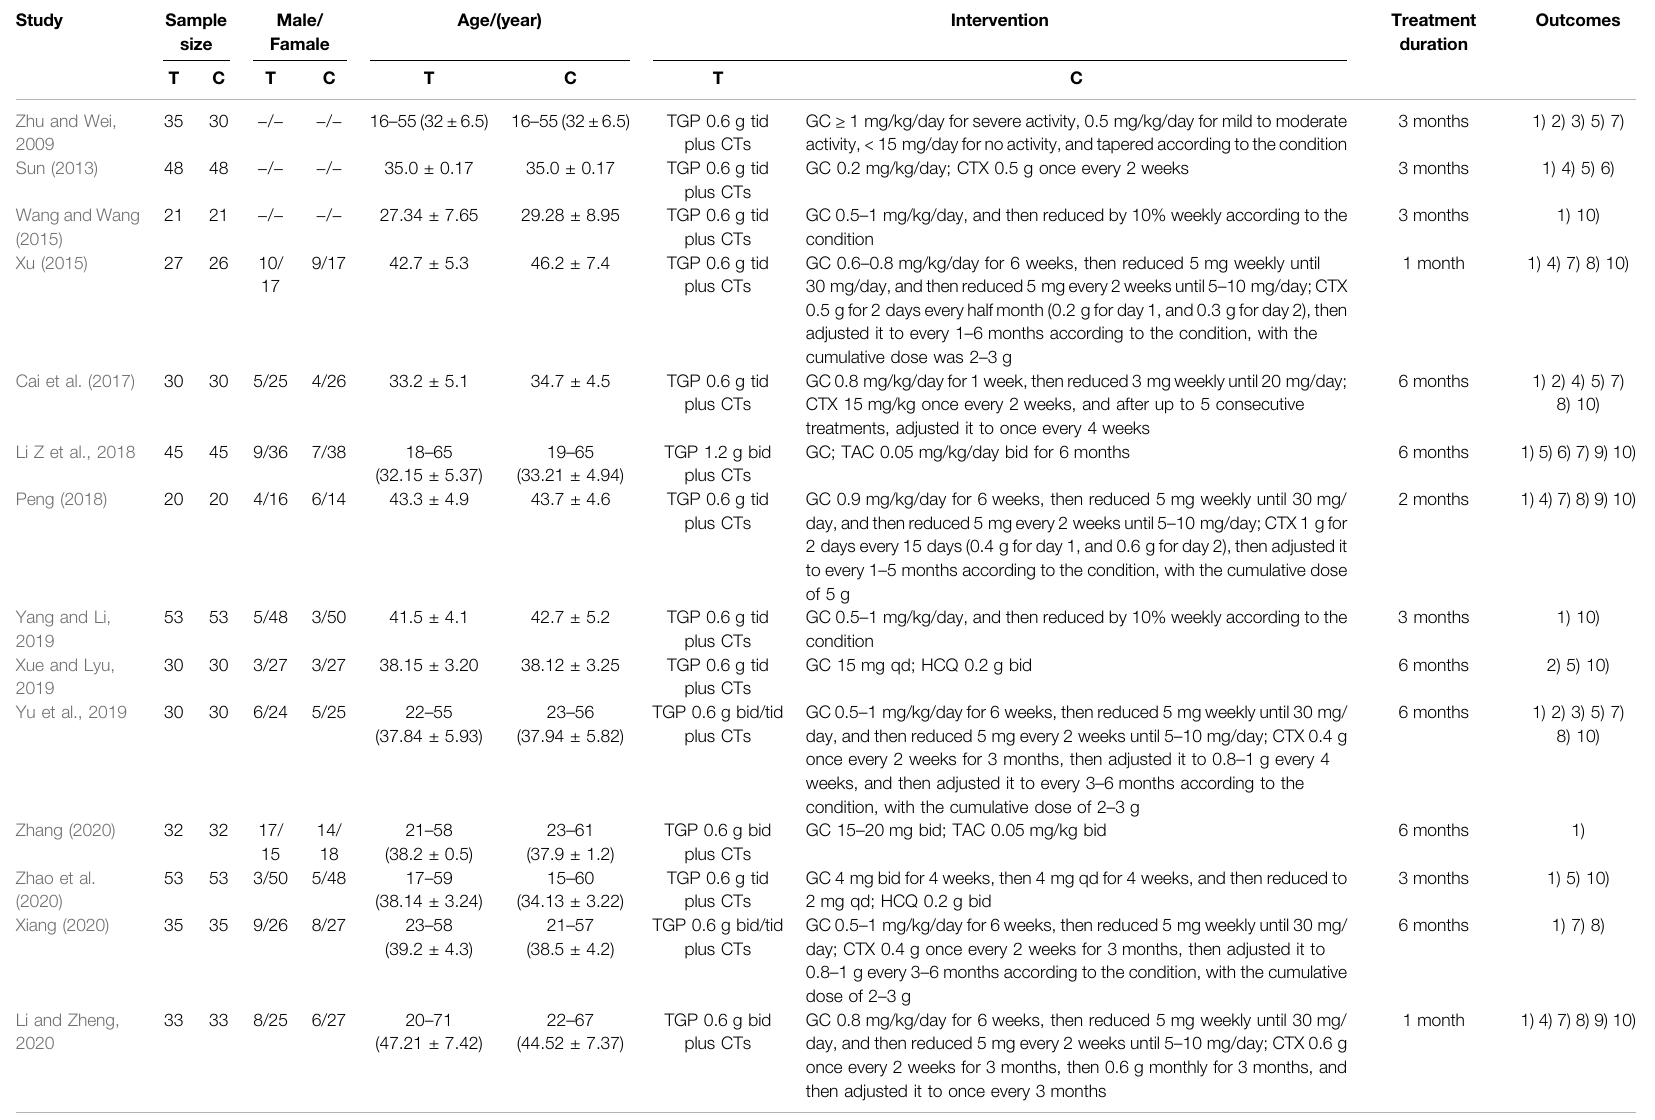
TABLE 1 | Basic characteristics of included